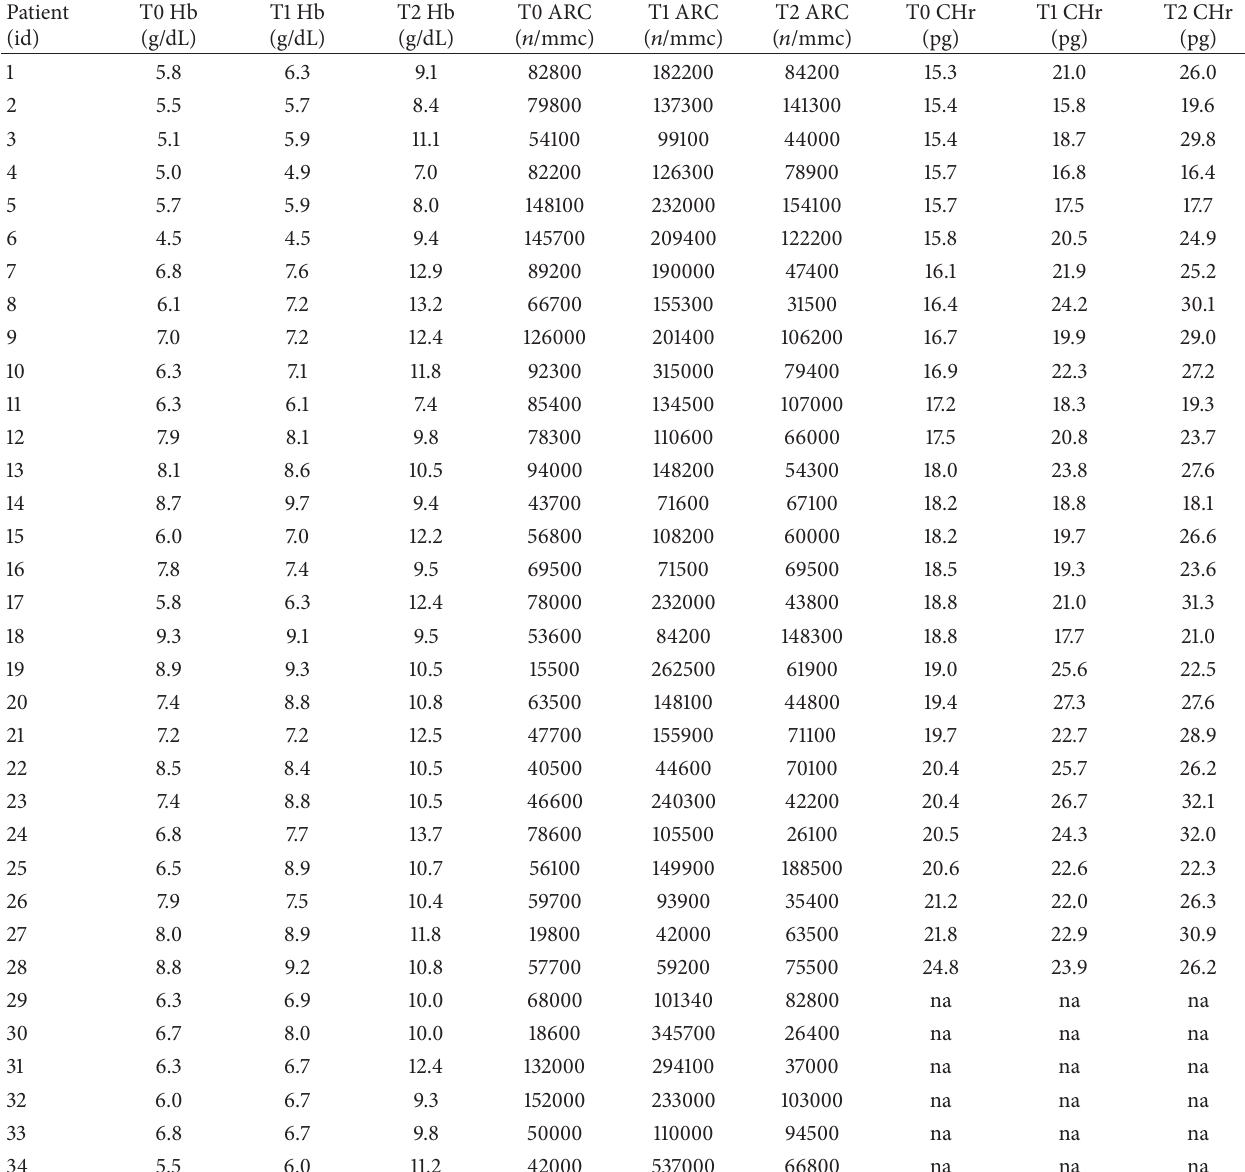
Table 2: Hemoglobin and reticulocyte parameters at T0 (before treatment), T1 (within 7 days from the beginning of oral iron), and at T2 (day +30 from the beginning of